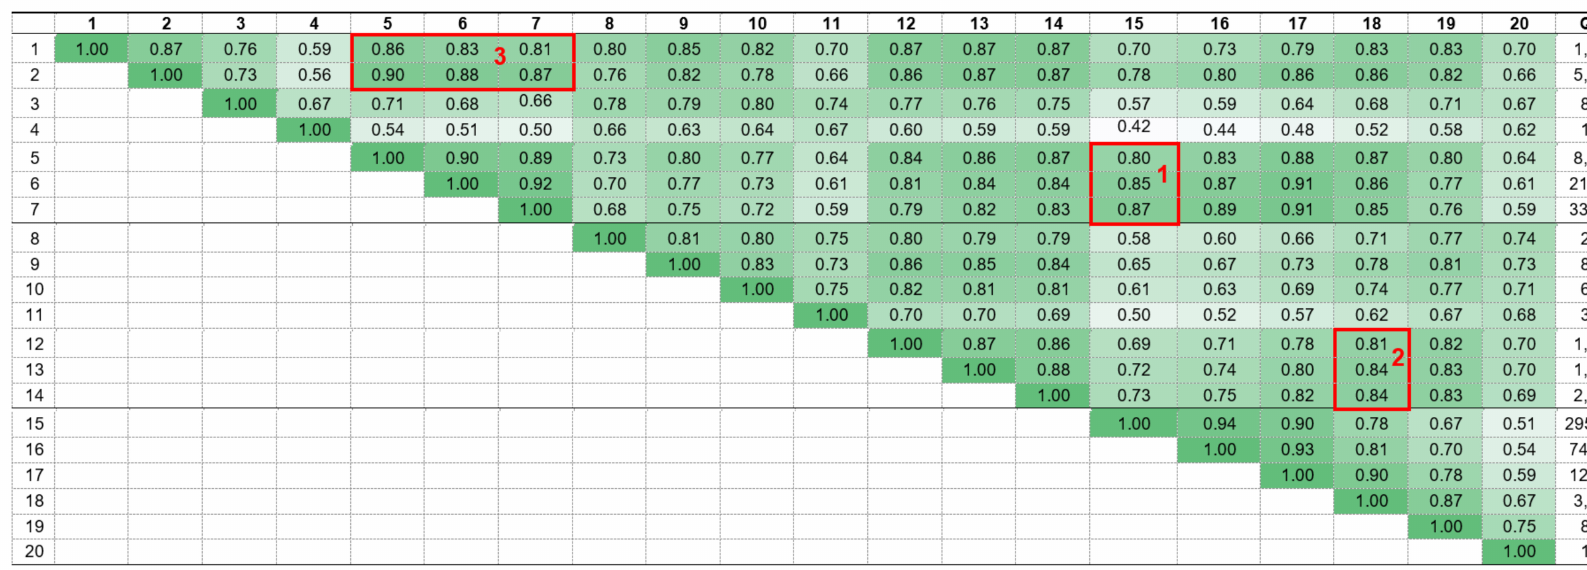
Table 8. Pearson correlation matrix between generated